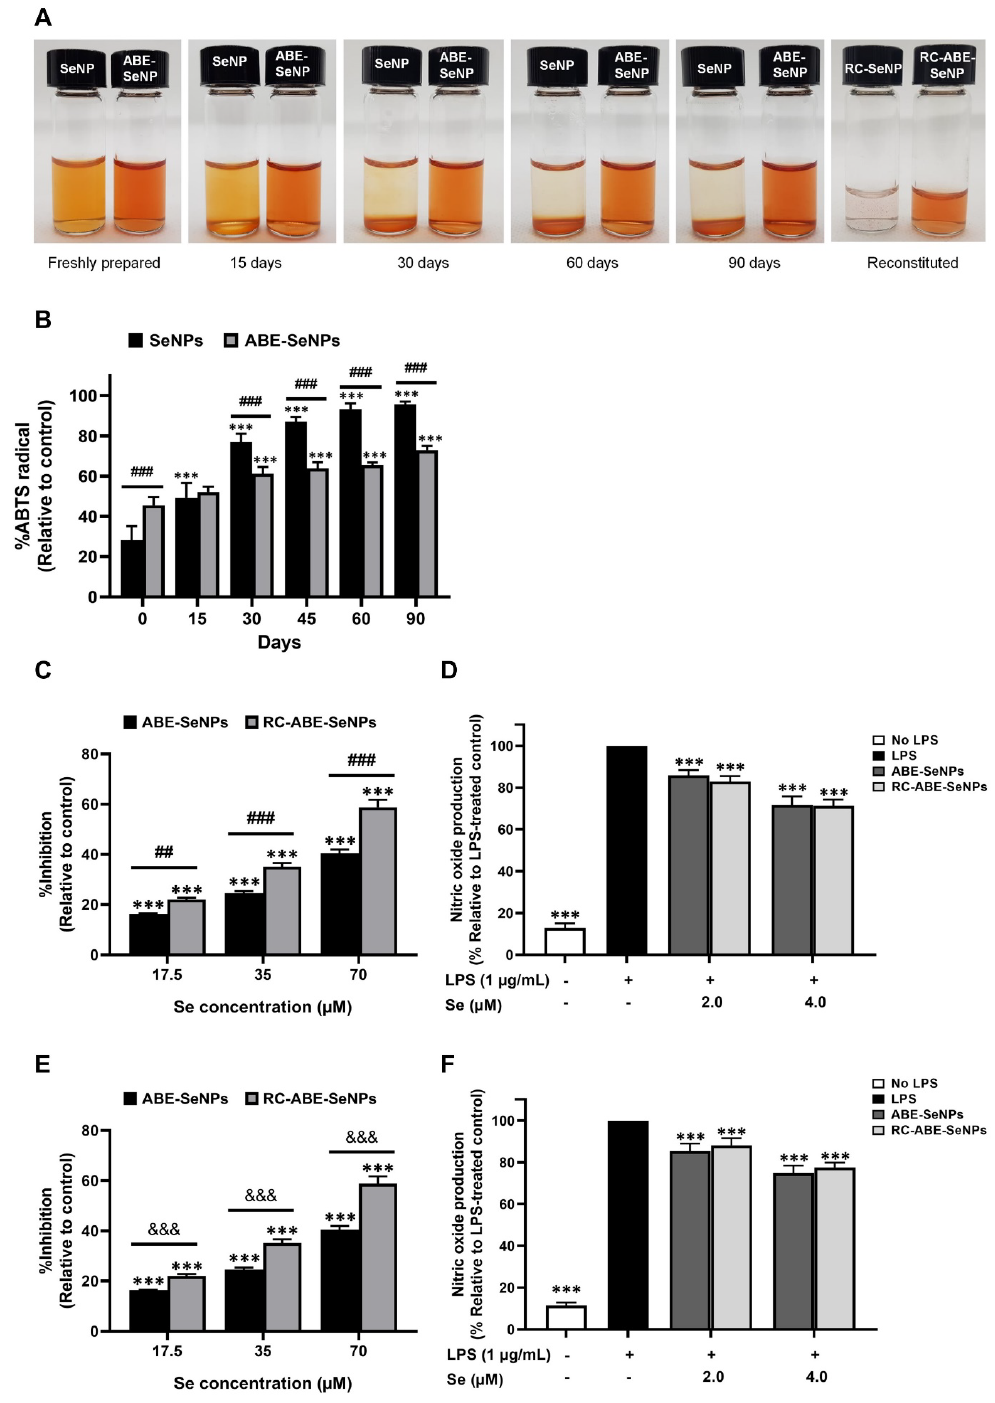
Figure 4. Stability of ABE-SeNPs is greater than SeNPs. Visual observation of SeNPs and ABE-SeNPs after fresh preparation, different times of storage, and reconstitution ( A ). Free radical scavenging activity of SeNPs and ABE-SeNPs (Se concentration, 70 µ M) determined by ABTS assay after storage for 15, 30, 60, and 90 days at 4 ◦ C ( B ). ABTS radical scavenging activity ( C ), and anti-inflammatory ability investigated by nitric oxide production ( D ) of ABE-SeNPs and RC-ABE-SeNPs. Free radical scavenging ( E ), and anti-inflammation ( F ) activities of ABE-SeNPs and RC-ABE-SeNPs after storage at 4 ◦ C for 30 days. (*** p < 0.001 compared to control, ## p < 0.01, ### p < 0.01 SeNPs compared to ABE-SeNPs, &&& p < 0.001 ABE-SeNPs compared to RC-ABE-SeNPs. The data indicated as mean ± SD of three independent